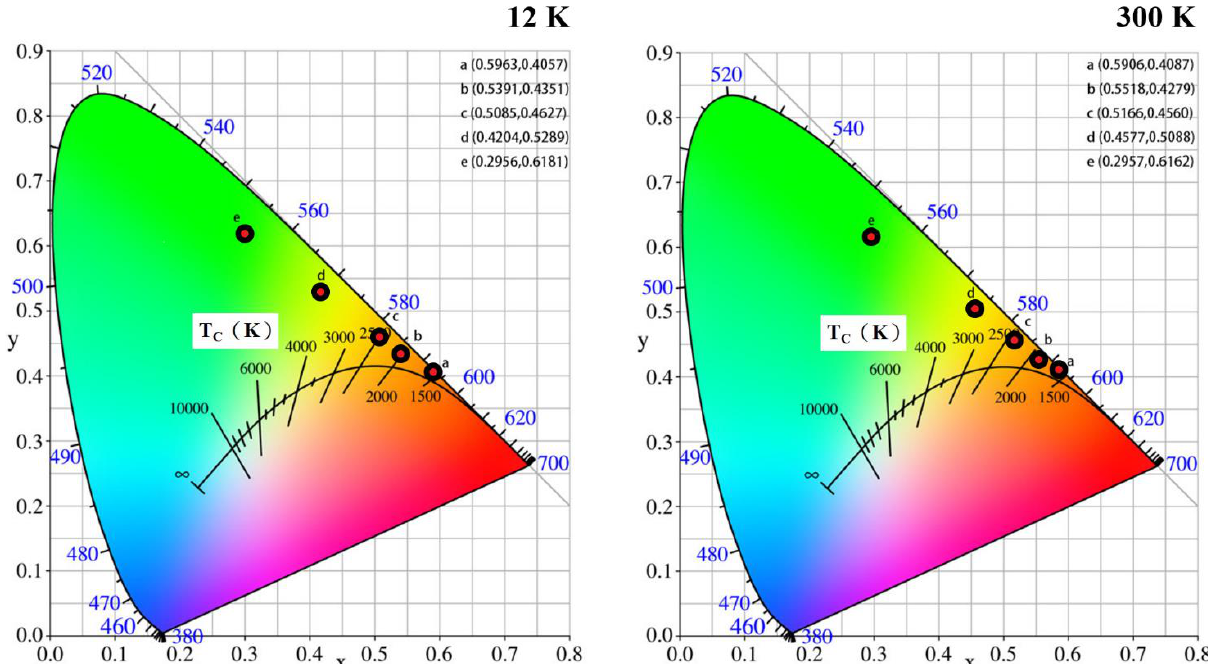
Figure 5. CIE coordinate of CaMoO 4 doped with different molar ratio of Sm 3+ /Tb 3+ ions calculated based on theirs 12 and 300 K PL spectra.